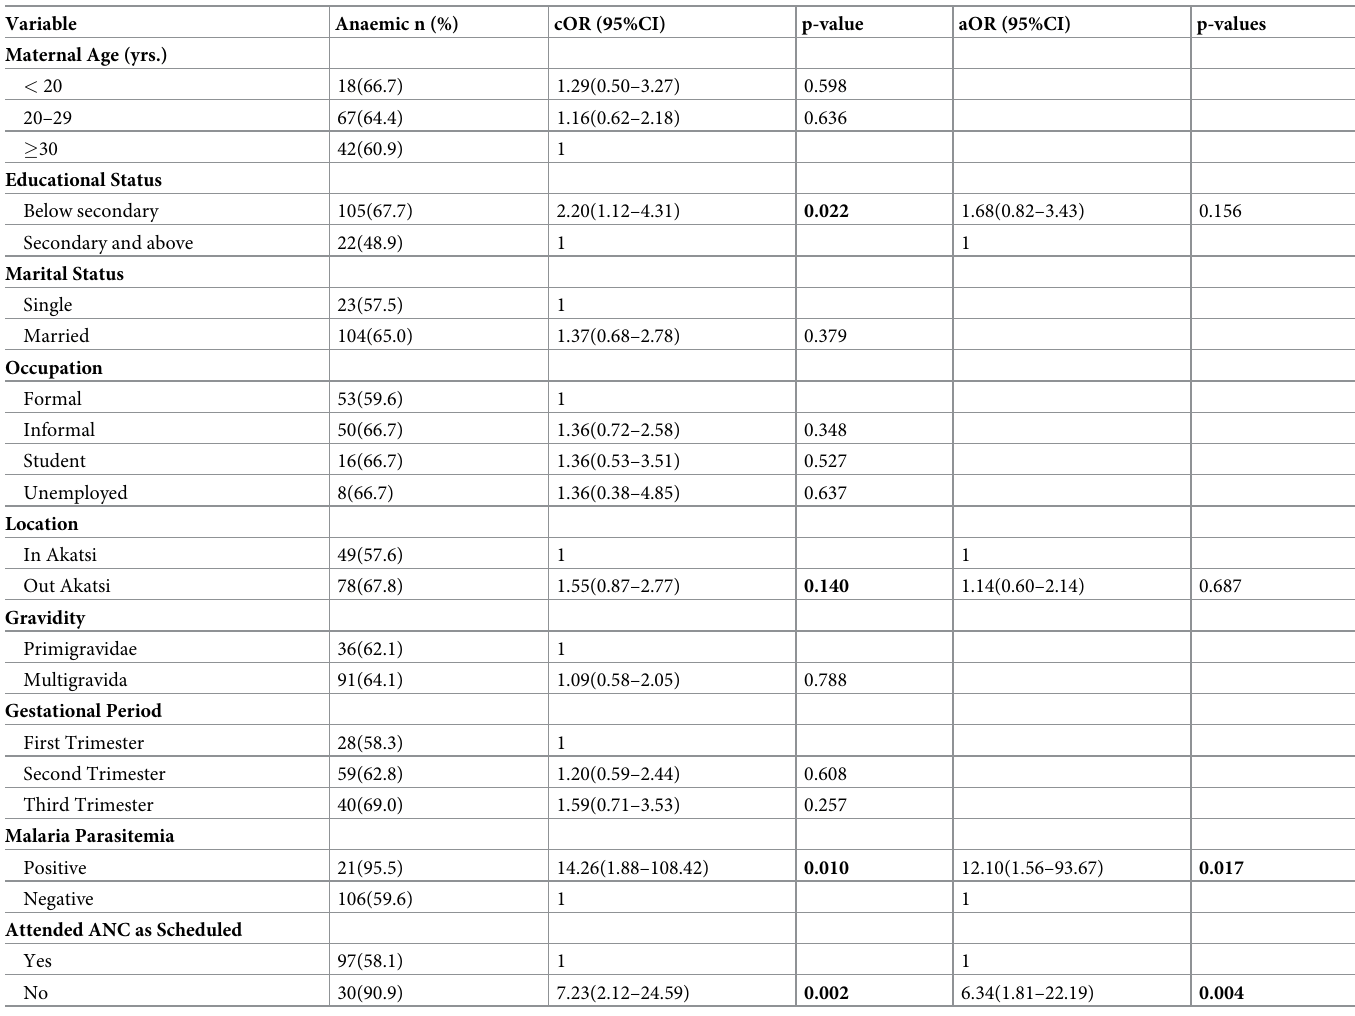
Table 5. Factors associated with anaemia in pregnant women, Akatsi South District,